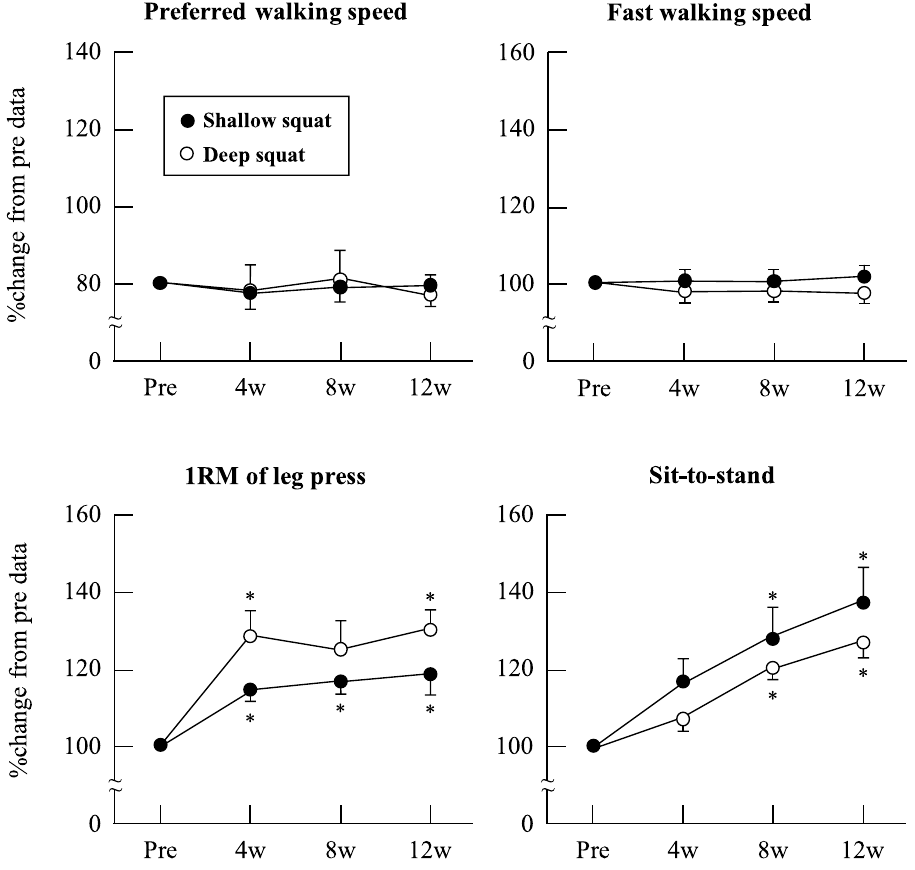
Figure 4. Relative changes in physical functional test results as a consequence of squat training in the shallow squat and deep squat groups. Error bars show standard error (SE). * P < 0.05 vs.